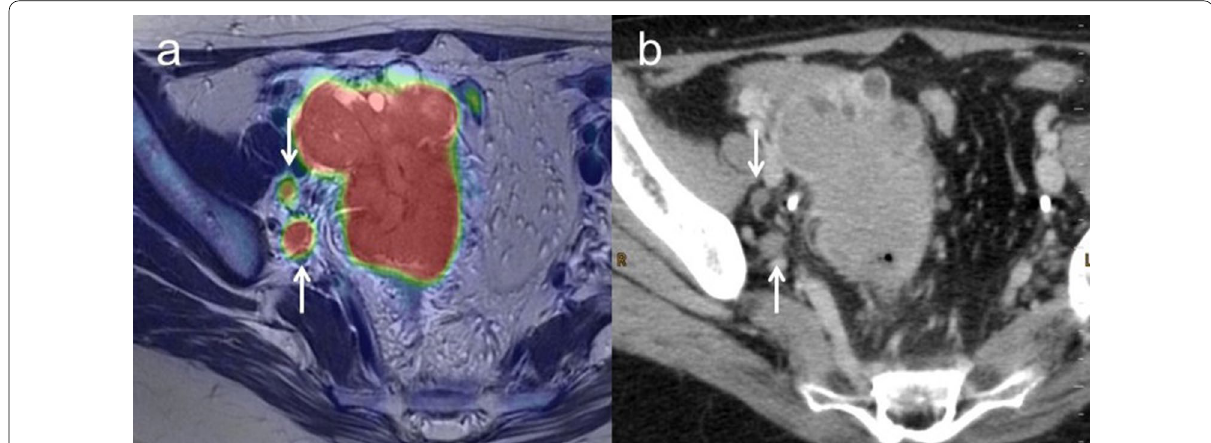
Fig. 3 a A 50-year-old woman with pathologically confirmed ovarian cancer. Axial T2-weighted PET/MR image shows right pelvic lymph nodes with FDG uptake (arrow). b Contrast-enhanced CT shows right pelvic lymph nodes less than 1 cm in short-axis diameter without enhancement (arrow). After NAC, these lymph nodes are decreased in size and SUV, suggesting these nodes as a sign of malignancy (N1)